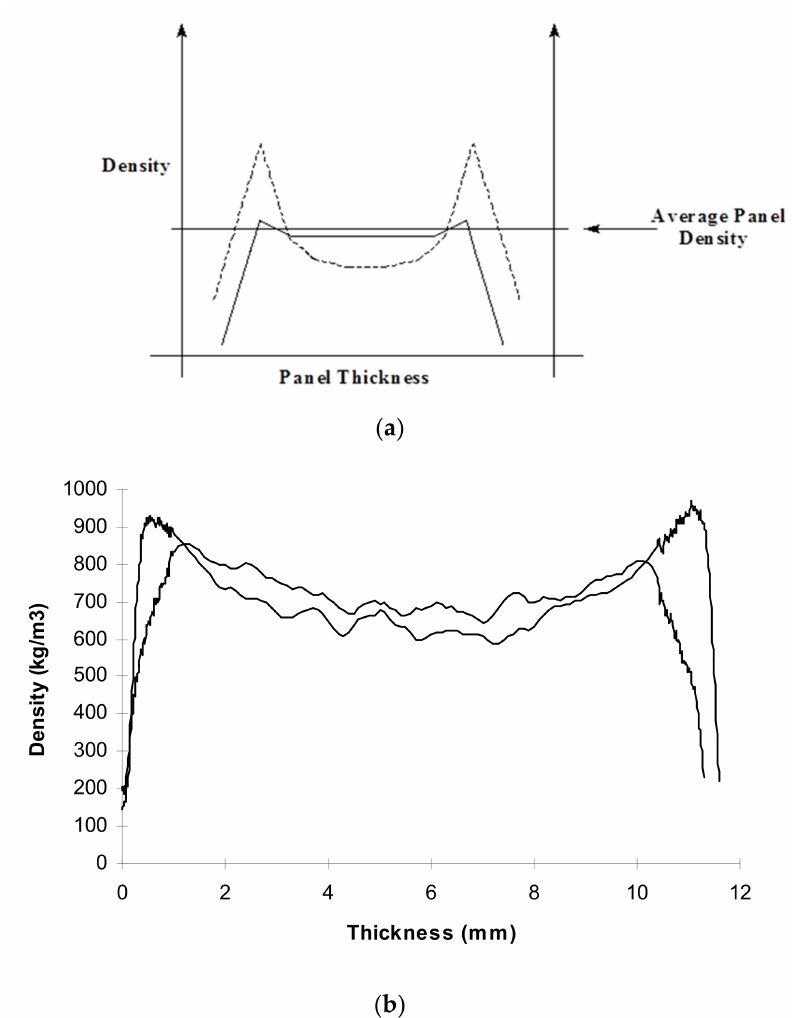
Figure 1. ( a ) Schematic, exaggerated representation of two di ff erent panel density profiles along the panel thickness leading to very di ff erent board properties; ( b ) an example of two real, di ff erent density profiles of two di ff erent wood particleboards